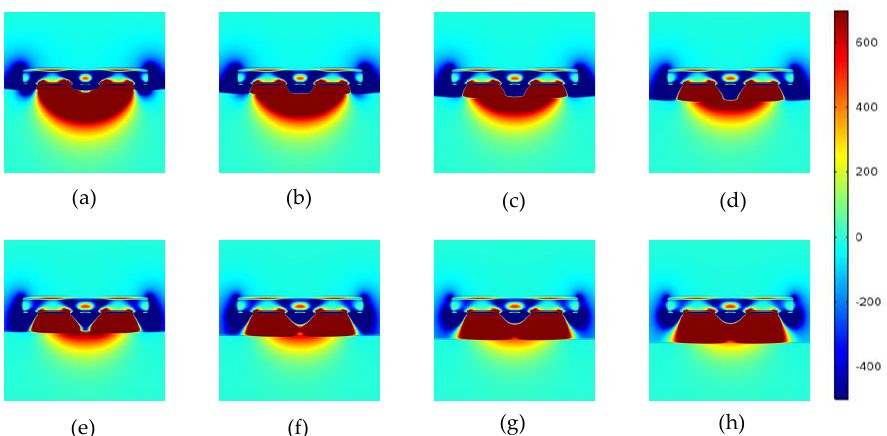
Figure 6. MSD variations with increased lift-offs for a non-conducting specimen. MSDs at ( a ) 0.5 mm, ( b ) 1 mm, ( c ) 1.5 mm, ( d ) 2.0 mm, ( e ) 2.5 mm, ( f ) 3.0 mm, ( g ) 3.5 mm, and ( h ) 4.0 mm lift-offs.